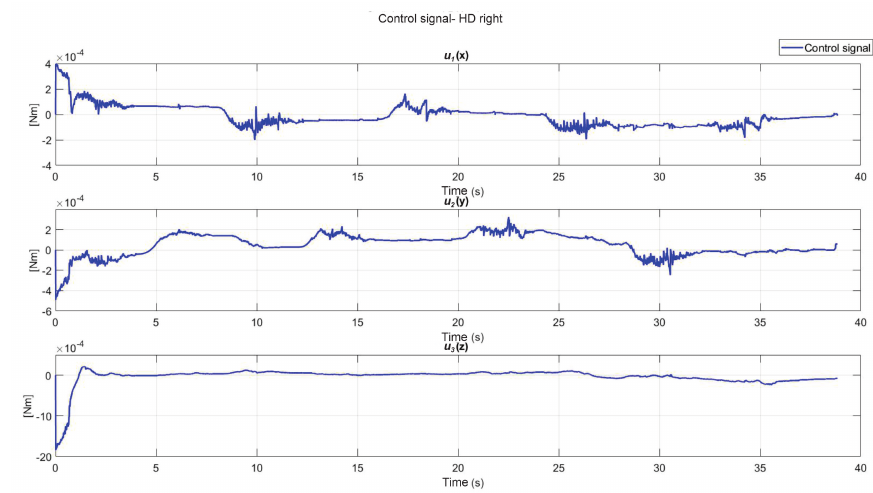
Figure 21. Right haptic device control signal: exercise 1.